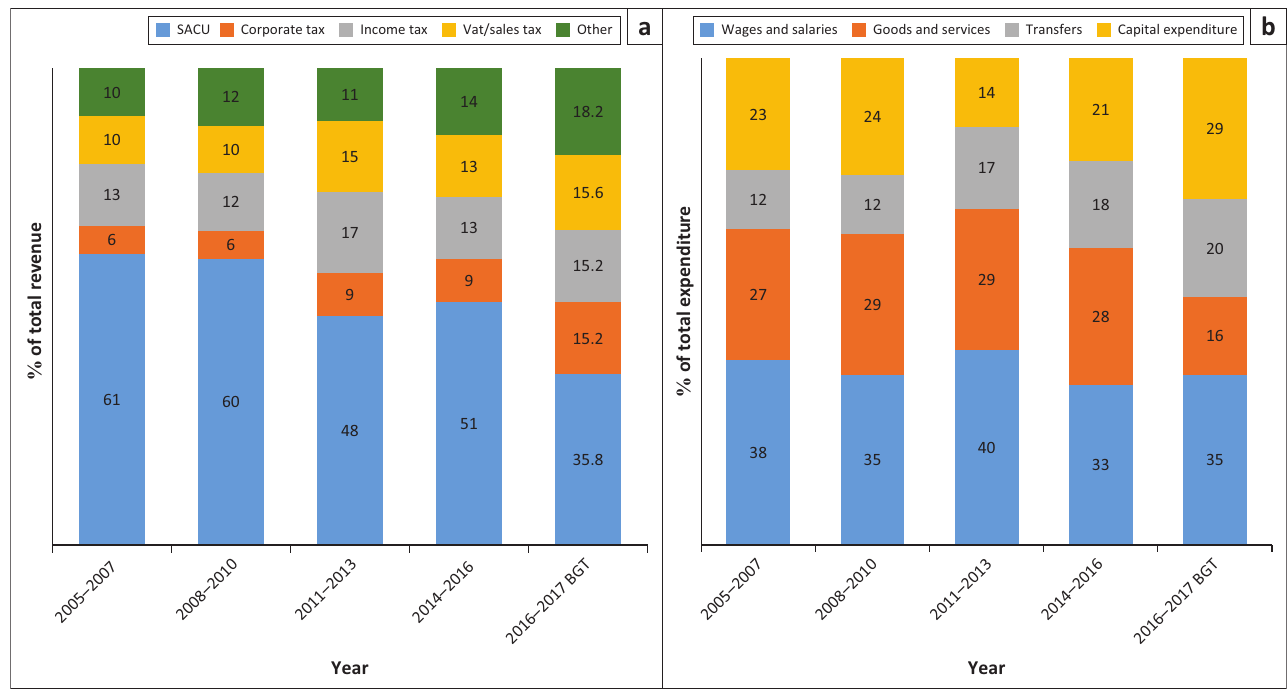
FIGURE 2: Composition of (a) government revenue and (b) government